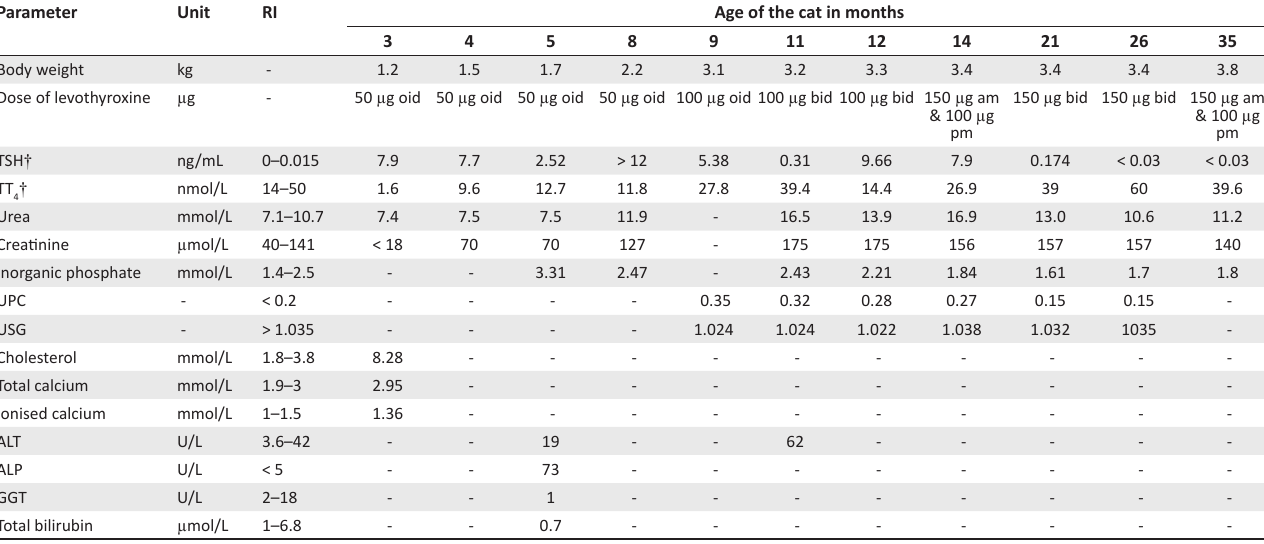
TABLE 1: Serial measurements of thyroid stimulating hormone, total thyroxine, selected serum biochemistry parameters, urine specific gravity, urine protein to creatinine ratio with monitoring of body weight and dose of levothyroxine supplement over the first 35 months of the kitten’s age. Parameter Unit Body weight Dose of